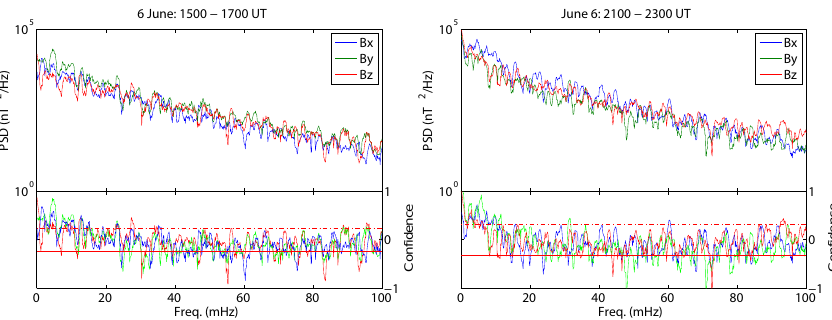
Figure 3. Left-top: power spectra of the three magnetic field components (in CSEQ coordinates) on 6 June between 15:00 and 17:00UT. Left-bottom: fourth-order polynomial detrended spectra with ± 95% confidence levels indicated by horizontal solid and dash-dotted red lines. Top- and bottom-right: Same as left for 6 June 21:00–23:00UT.